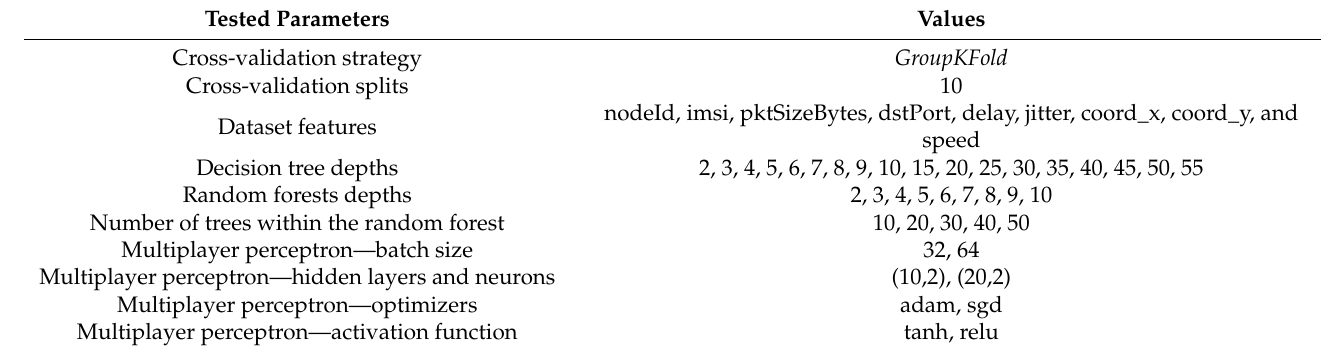
Table 4. Summary of tested